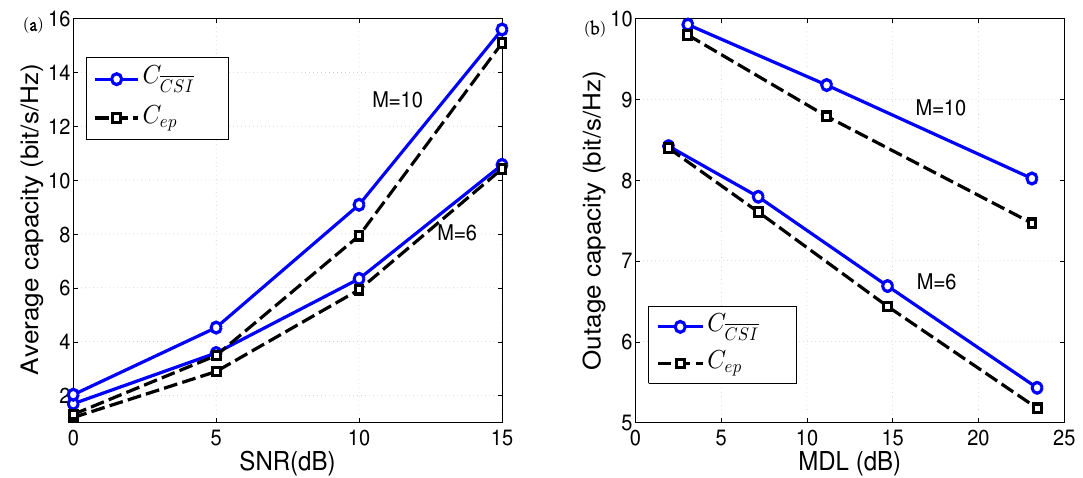
Figure 2. ( a ) Average capacities vs. SNR for M = 6,10 modes for MDL = 20 dB; ( b ) Outage capacities vs. MDL for M = 6,10 modes for SNR = 10